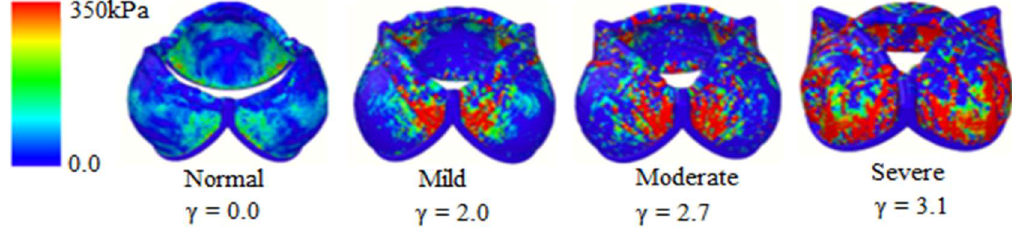
Figure 7. Mechanical stress on the valve leaflets at maximal opening.